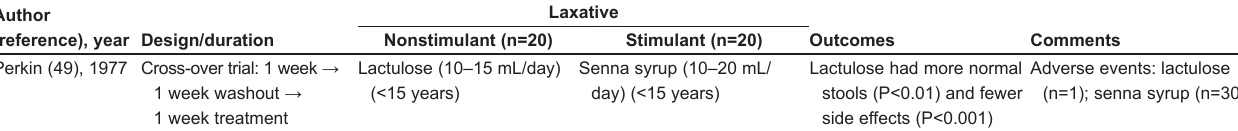
Table 4 Summary of a clinical trial comparing nonstimulant versus stimulant laxatives